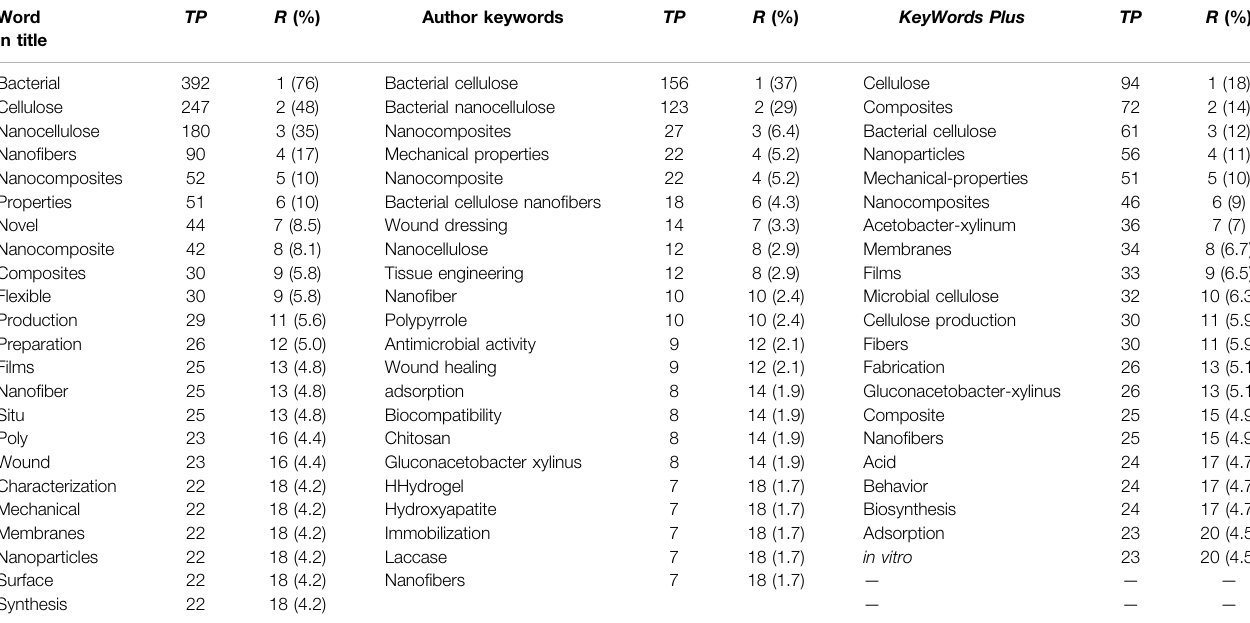
TABLE 5 | The top 20 most used words in title, author keywords, and KeyWords Plus .